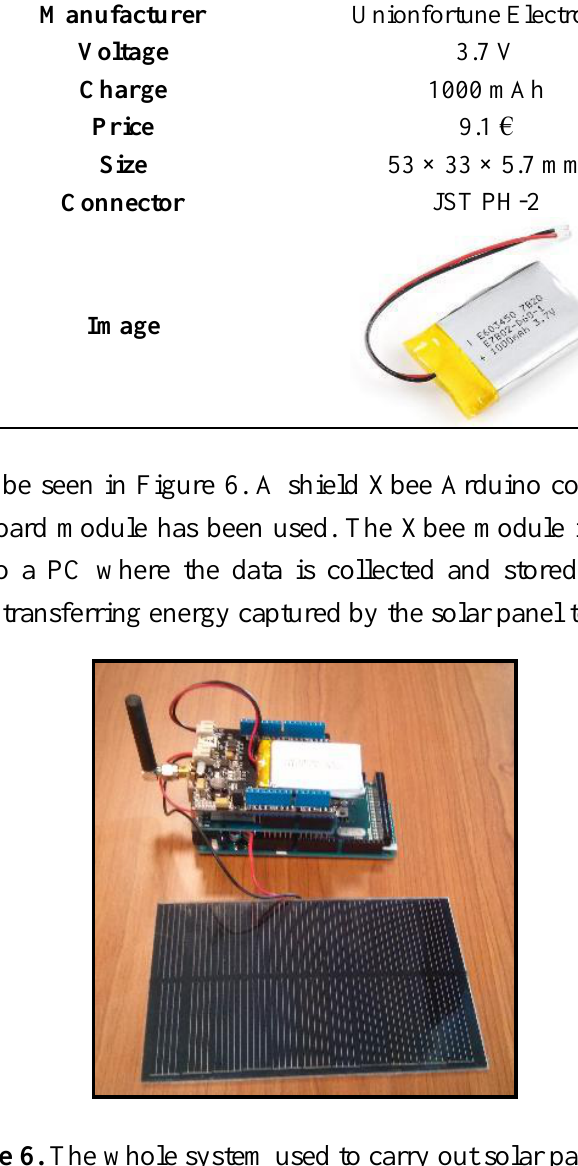
Figure 6. The whole system used to carry out solar panel